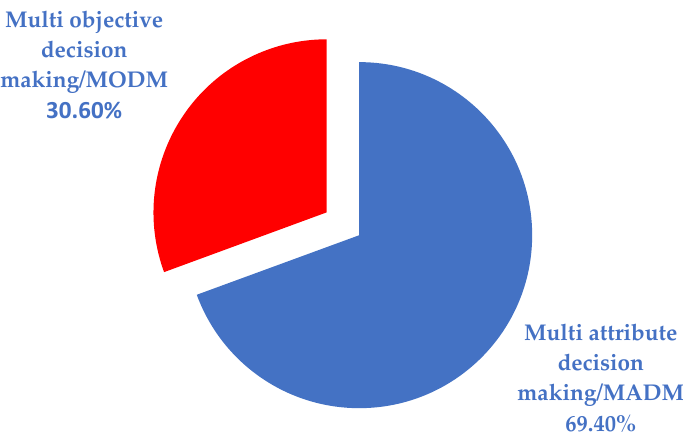
Figure 3. Percentages of Articles Focusing on MODM and MADM.